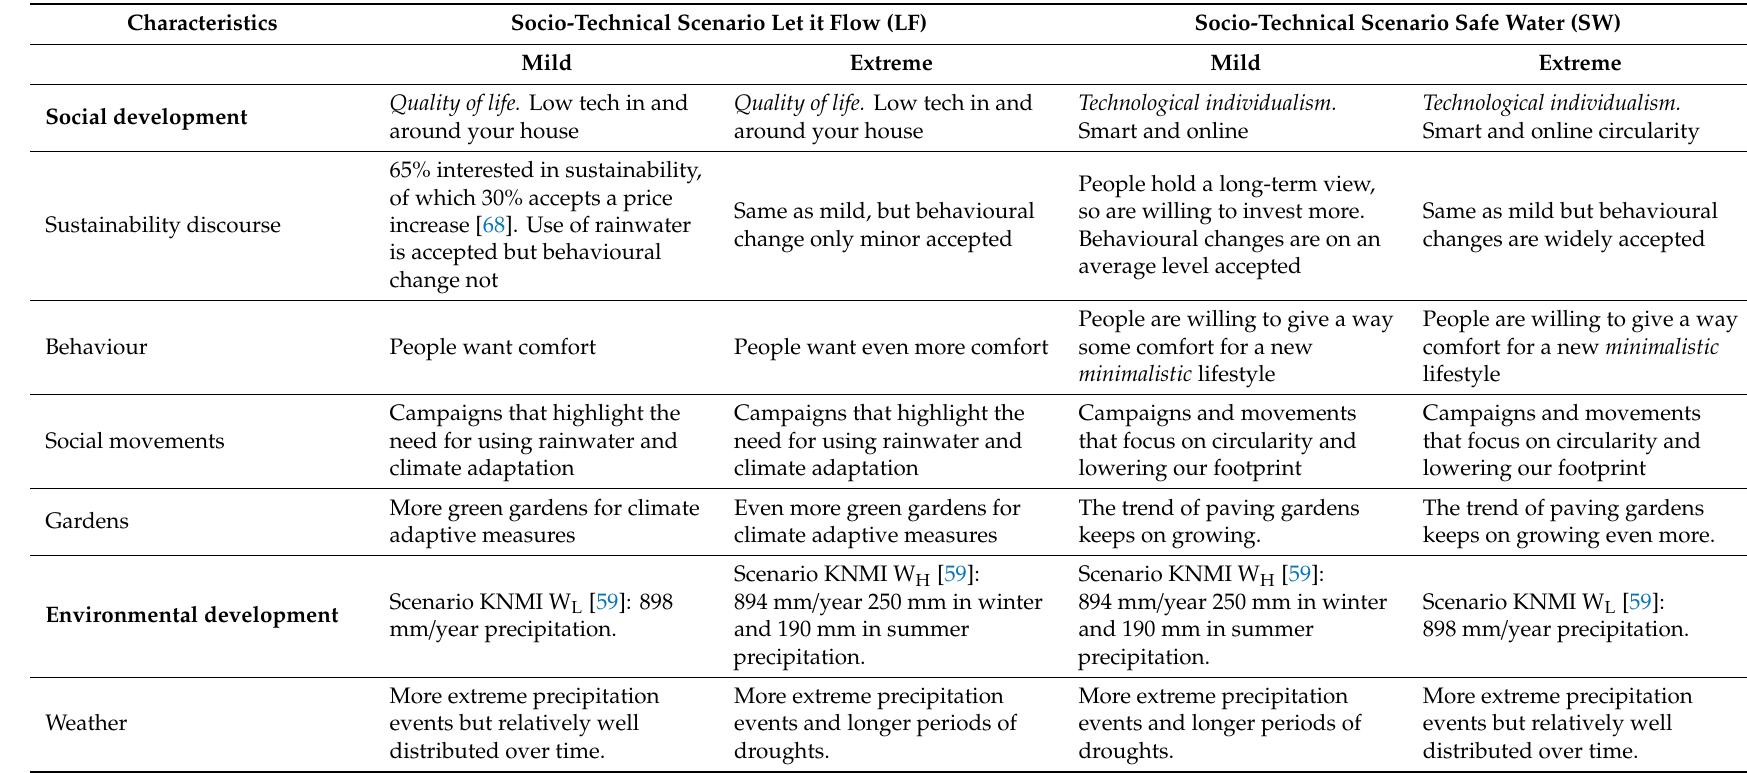
Table 4. Characteristics of the socio-technical scenarios: Let it flow (left) and Safe water